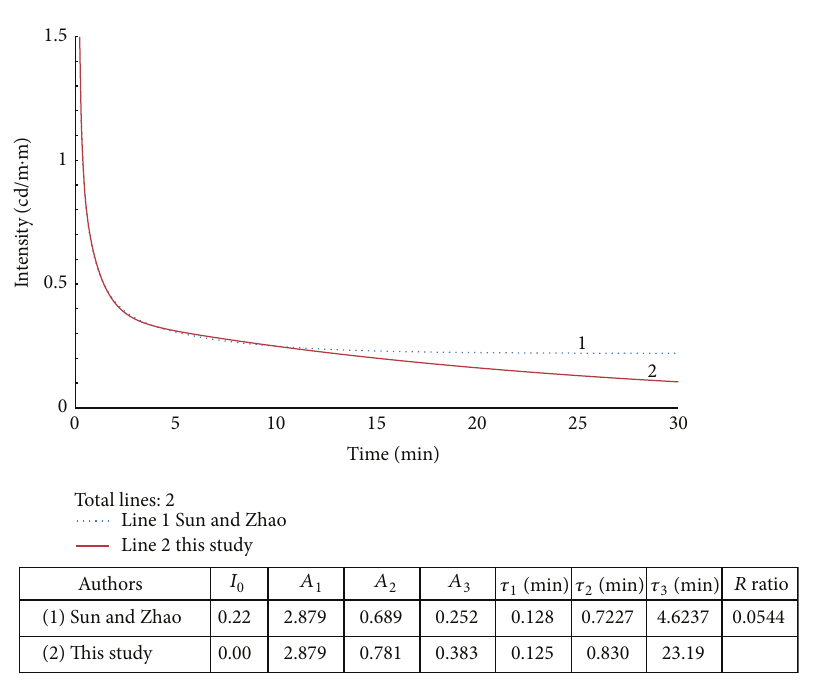
Figure 4: Example 1 with modified data from [7].